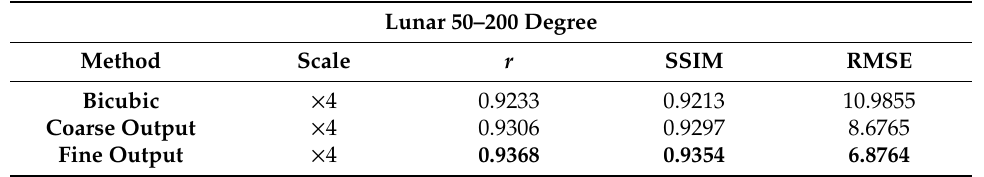
Figure 9. Visual comparison of 200-degree reconstructed spatial structure at ×4 scale of lunar gravity data. ( a ) GRAIL 200 degree; ( b ) Bicubic 200 degrees of the Moon ( × 4); ( c ) Coarse output 200 degree of the Moon ( × 4); ( d ) Fine output 200 degree of the Moon ( × 4). Table 6. Quantitative indicators of Experiment